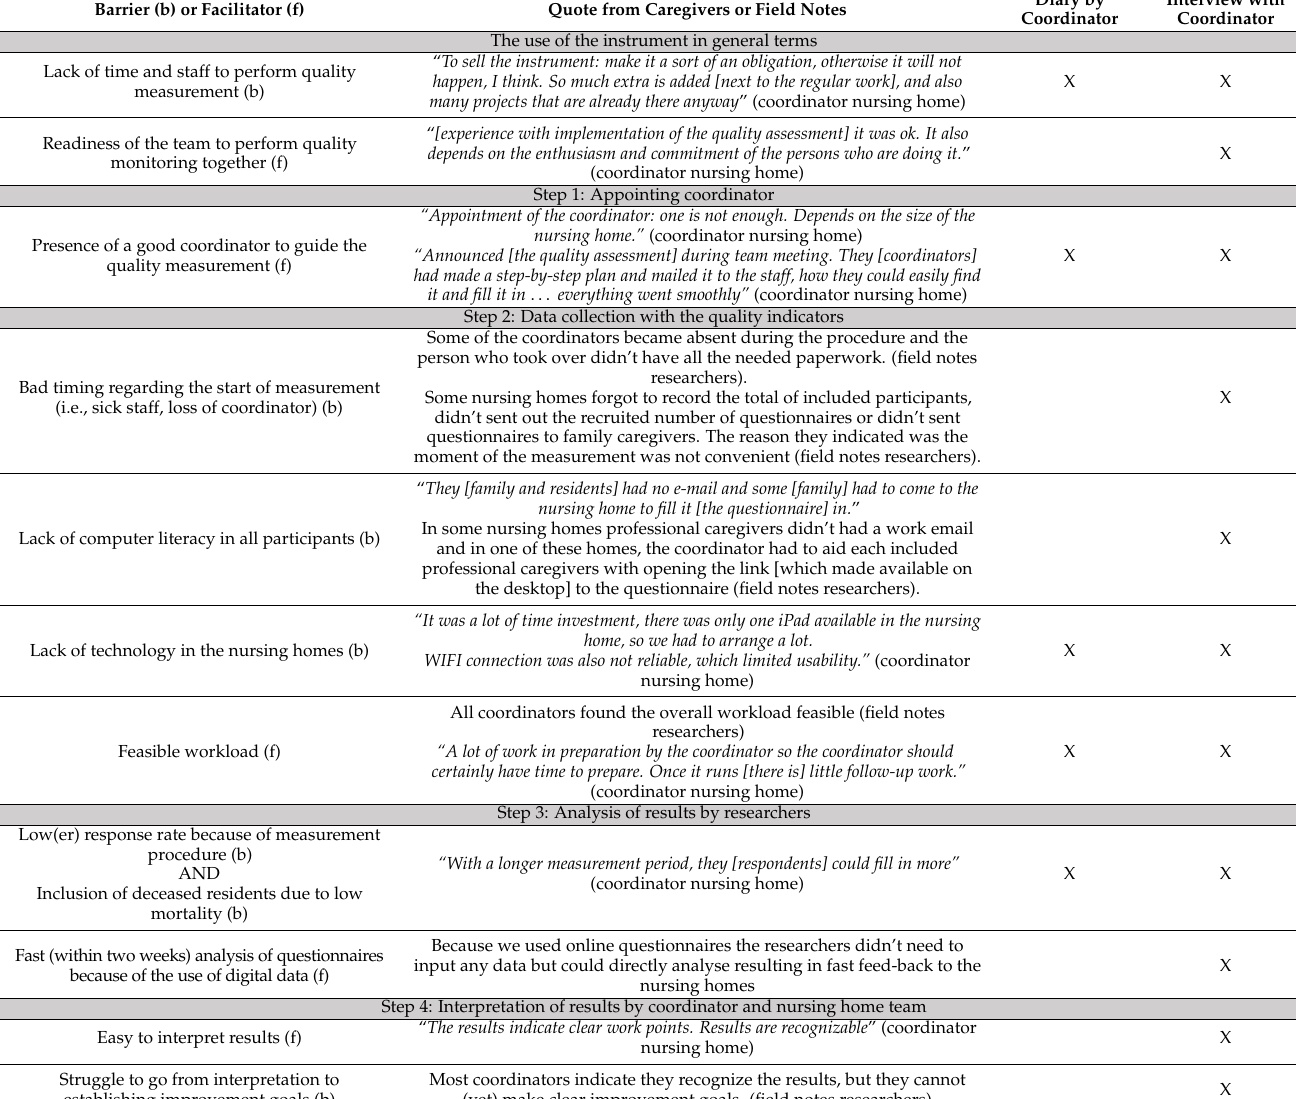
Table 6. Facilitators and barriers based on the interviews and dairies regarding the use of the instrument. Barrier (b) or Facilitator